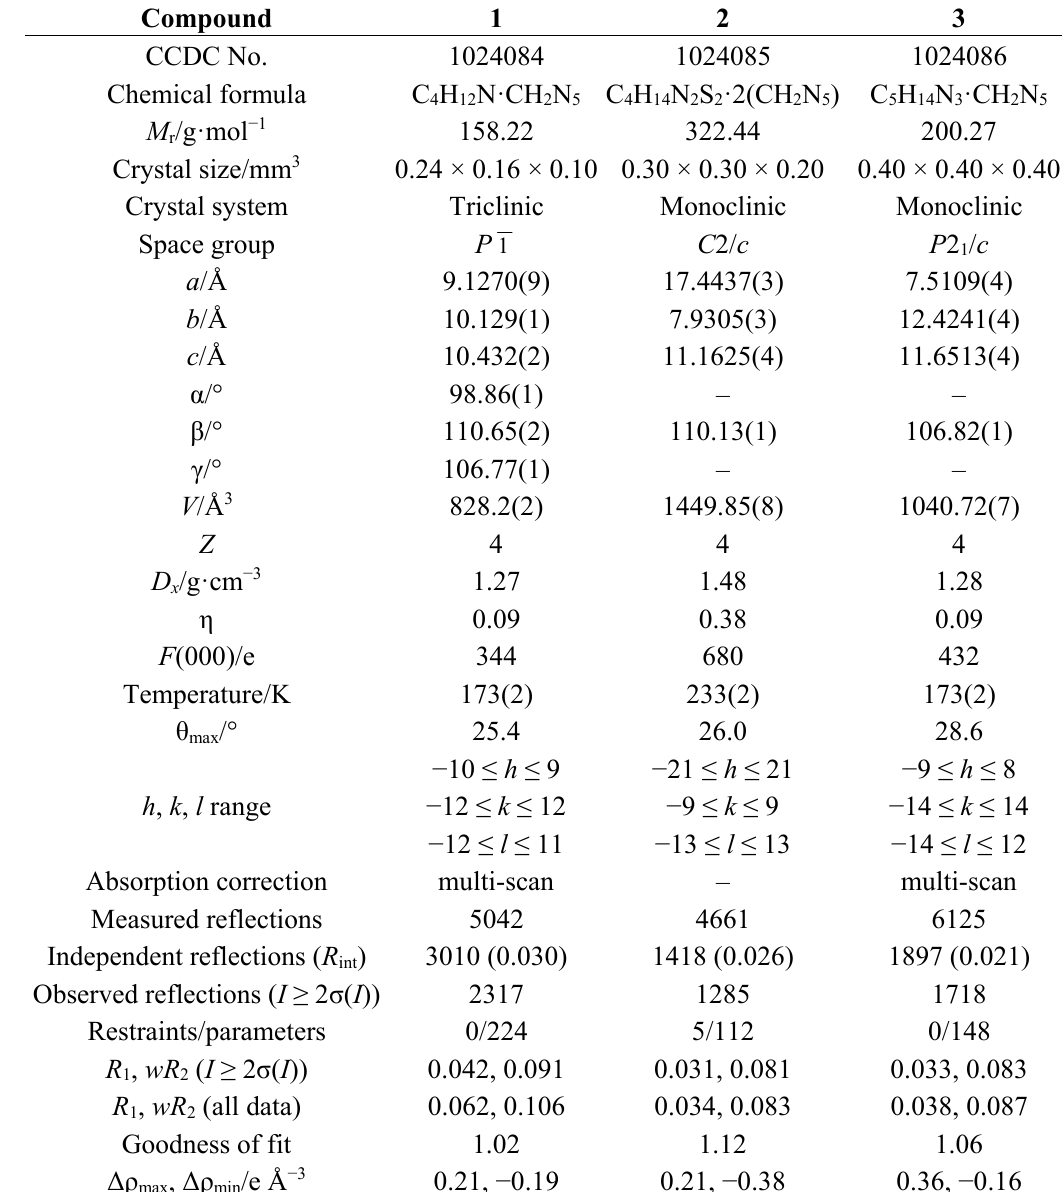
Table 1. Crystal data and structure refinement details for compounds 1 – 3